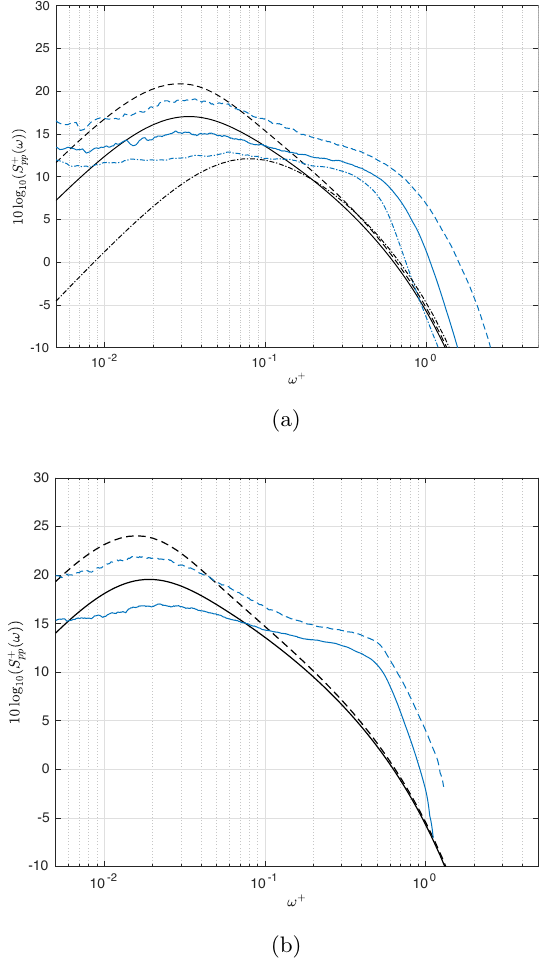
Figure 7. Comparison of modelled (black) and measured (blue) spectra at (a) Re + = 2000 and (b) Re + = 4000 for apg (dashed), zpg (solid) and fpg (dash-dotted) conditions. See parameters in Table 1.